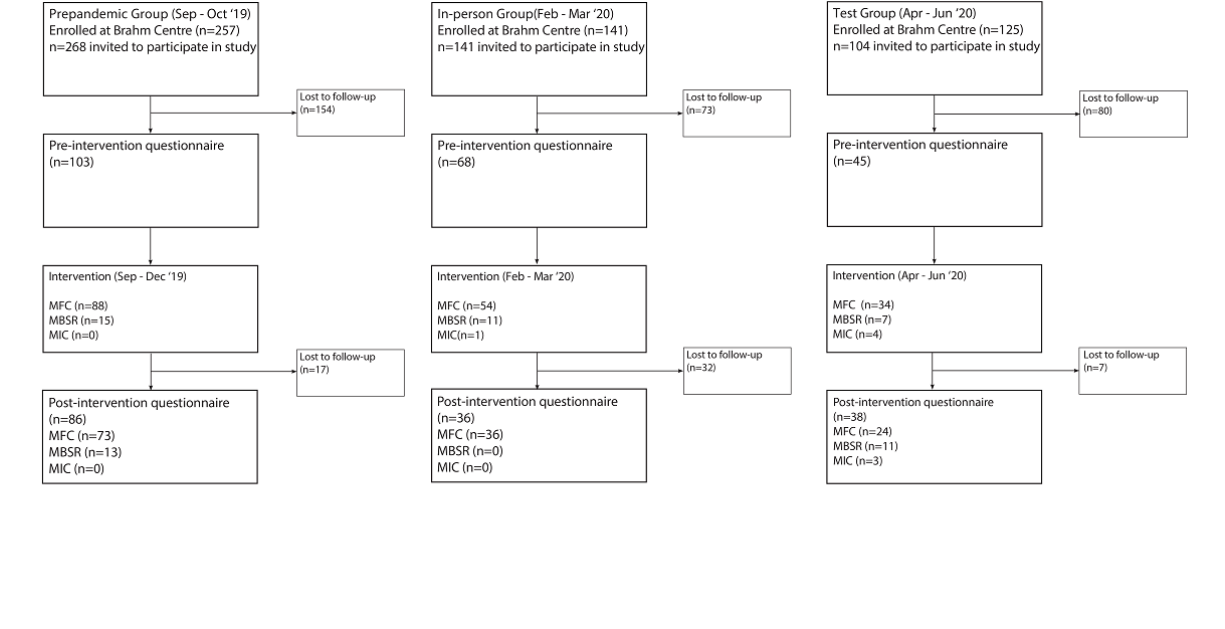
Figure 2. Diagram of participant flow throughout the protocol. Participants were enrolled in 1 of 3 types of mindfulness courses: 4-week